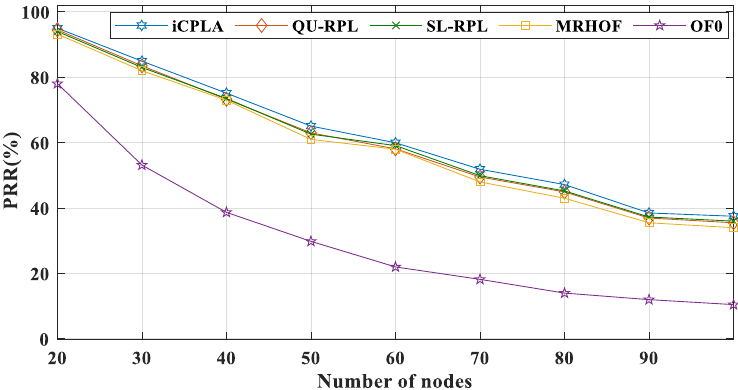
Figure 7. Comparison of packet reception ratio (PRR) between i CPLA, QU-RPL, SL-RPL, MRHOF, and OF0 with 𝛼 = 0.3 and 𝛽 = 0.7 in a network of 20 to 100 nodes.